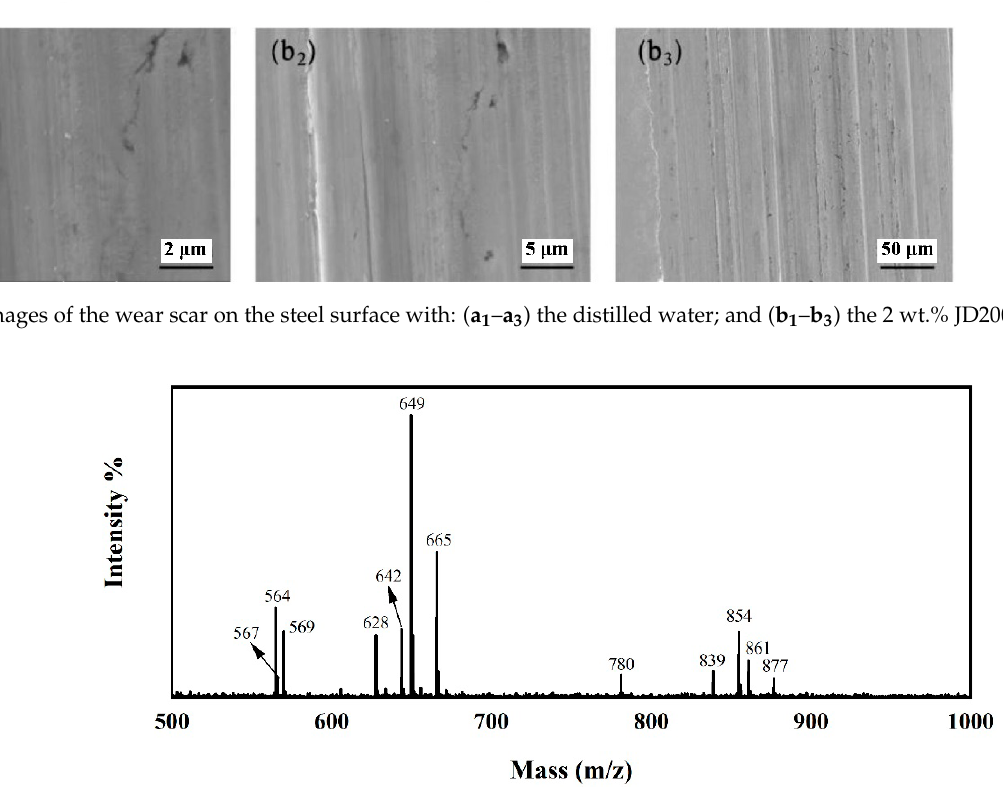
( b 1 – b 3 ) the 2 wt.% JD2000 aqueous solution.